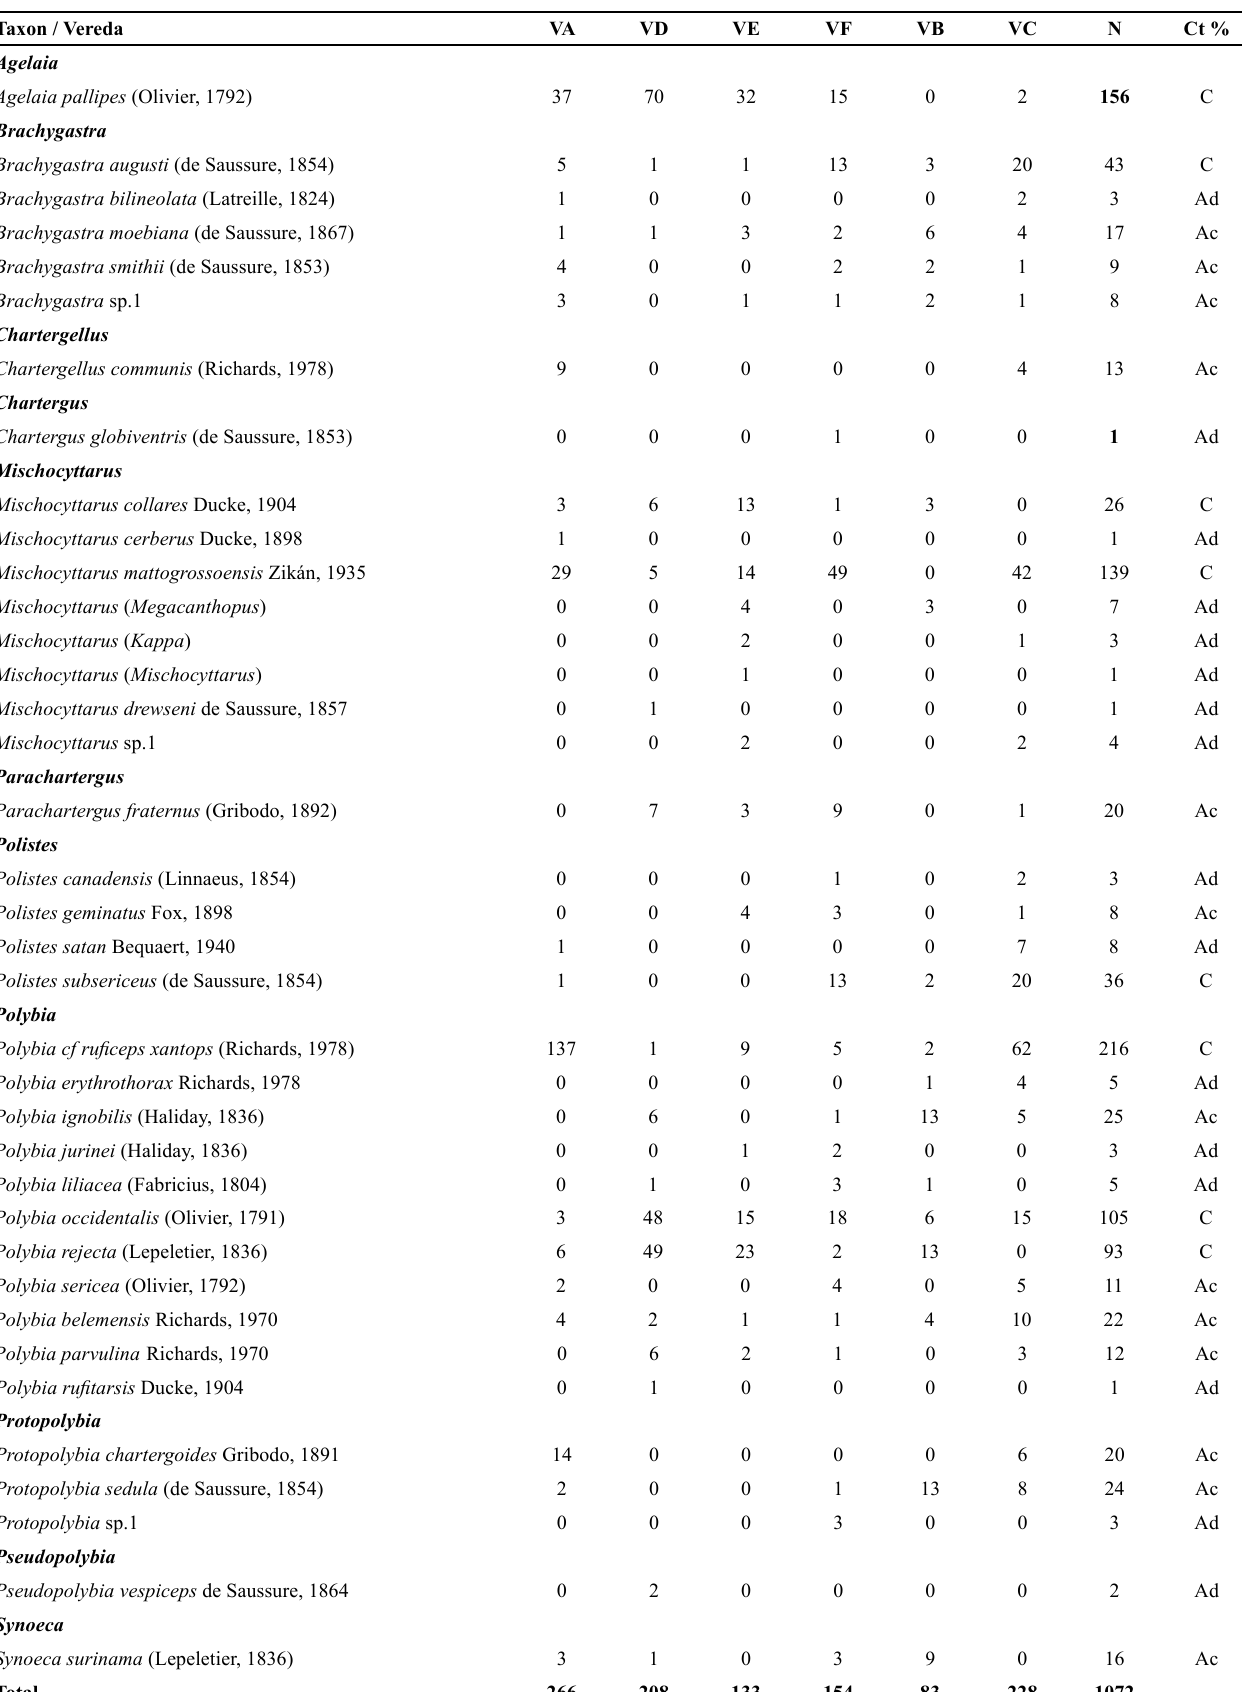
Table 2. Abundance of the social wasp species of the subfamily Polistinae recorded between August 2017 and July 2019 in the six study Veredas in the Cerrado–Amazon transition zone in the municipality of Nova Xavantina, in Mato Grosso state, central Brazil. VA = Botina stream, VD and VE = Chupador stream, VC = Areal stream, VF = Coronel Vanique stream, and VB = Queixada stream, Ct%